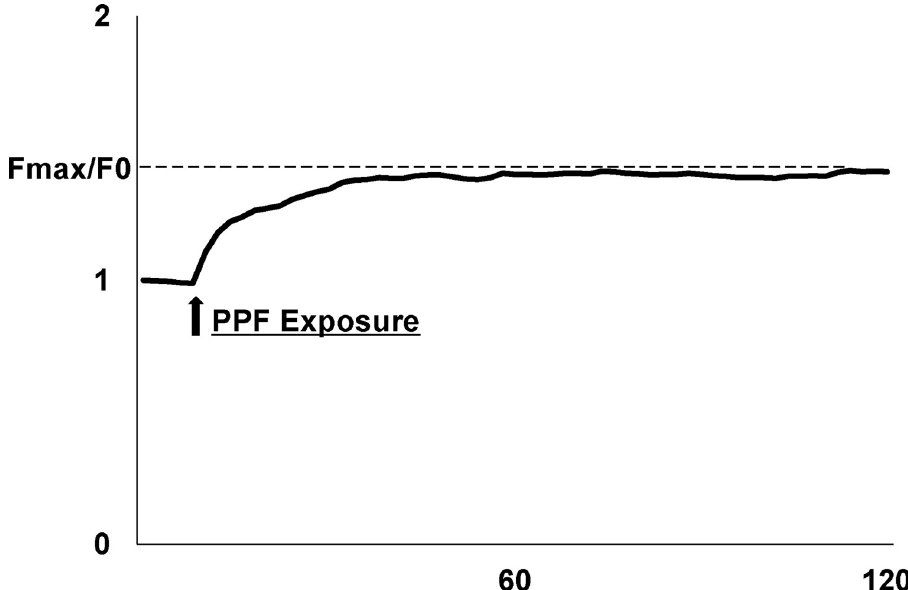
Fig 2. The intensity of the fluorescence (F/F0) over time in a cultured primary neuron. PPF application led to an increase in the temporal intracellular calcium concentration ([Ca 2+ ]i). The arrow indicates PPF exposure and onset. To evaluate the PPF application effect, we observed Fmax/F0 as height calculated from the [Ca2 +]i response in the neuron.